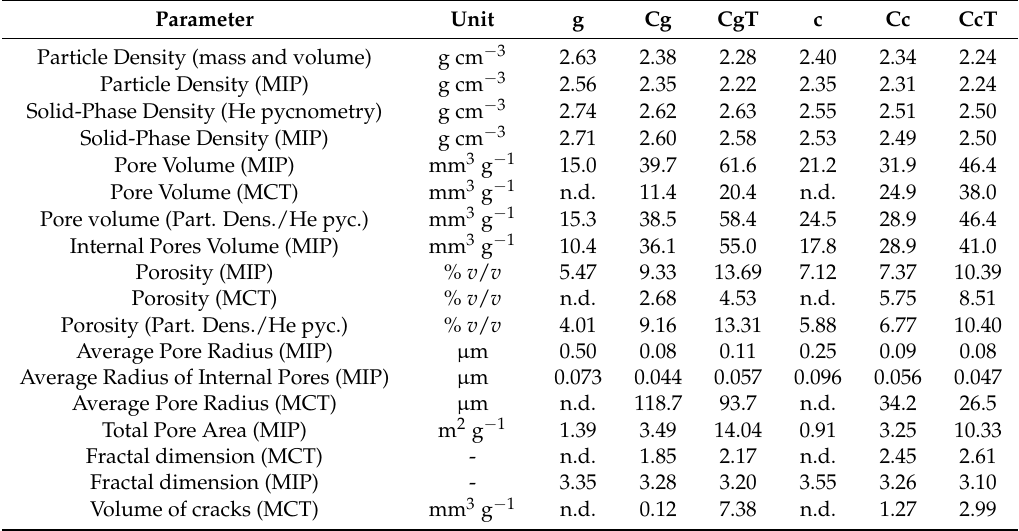
Table 1 compiles porosity parameters of the studied samples derived from the applied methods. Table 1. Porosity characteristics of the studied